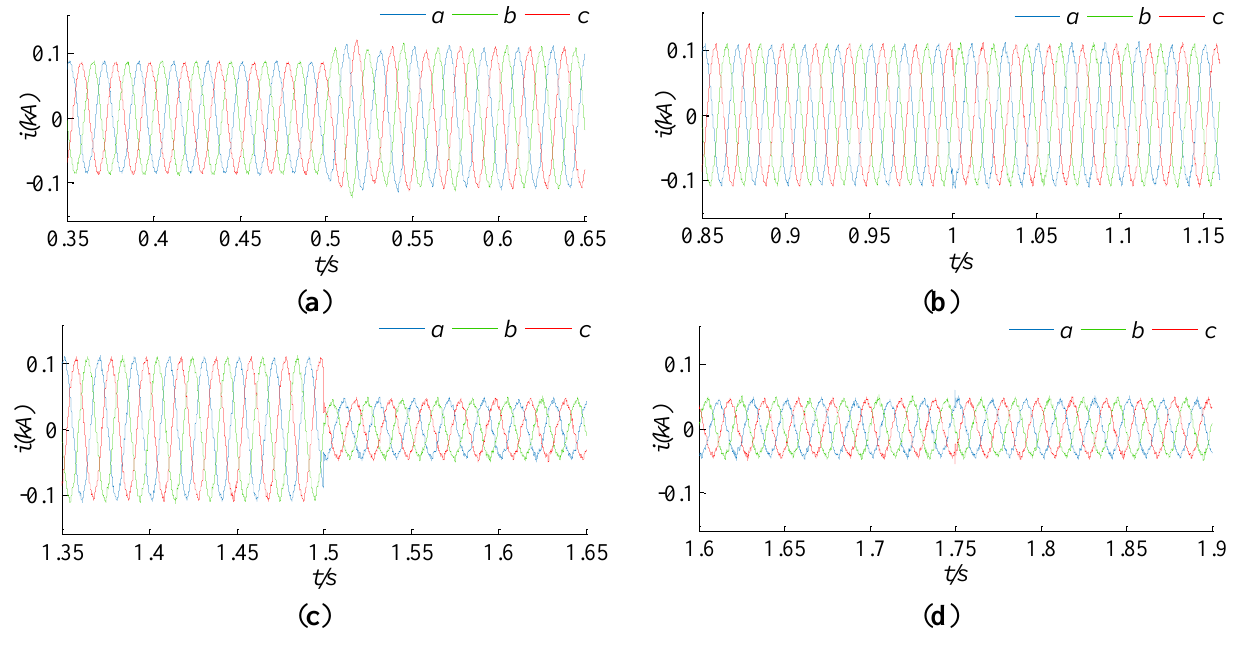
Figure 11. ( a ) Output current waveforms of DG PV between 0.35 s and 0.65 s; ( b ) Output current waveforms of DG PV between 0.85 s and 1.15 s; ( c ) Output current waveforms of DG PV between 1.35 s and 1.65 s; ( d ) Output current waveforms of DG PV between 1.6 s and 1.9